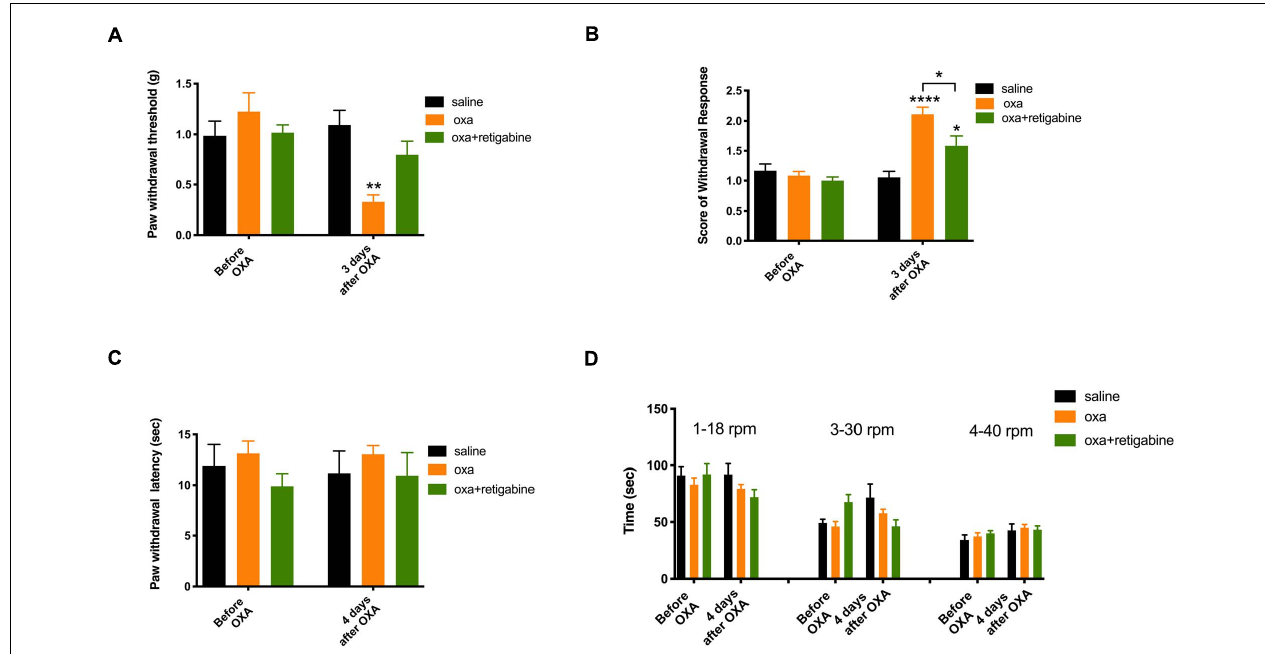
FIGURE 3 | Effects of retigabine on the sensory and motor behaviors following oxaliplatin treatment. Oxaliplatin (oxa, 5 mg/kg, ip) was administrated at Day 0. Retigabine (10 mg/kg, ip, daily) was treated at Day –2, Day –1, Day 0, Day 1, and Day 2. The same groups of animals were tested for mechanical and cold behaviors at Day 3, and were tested for heat and motor behaviors at Day 4. (A) Paw withdrawal threshold to Von-Frey filament; (B) Score of withdrawal response to acetone; (C) Paw withdrawal latency to radiant heat; and (D) Time stayed on rod at different speeds in rotarod tests ( n = 6 for all groups). *, P < 0.05; **, P < 0.01; ****, P < 0.0001; two-way repeated measure